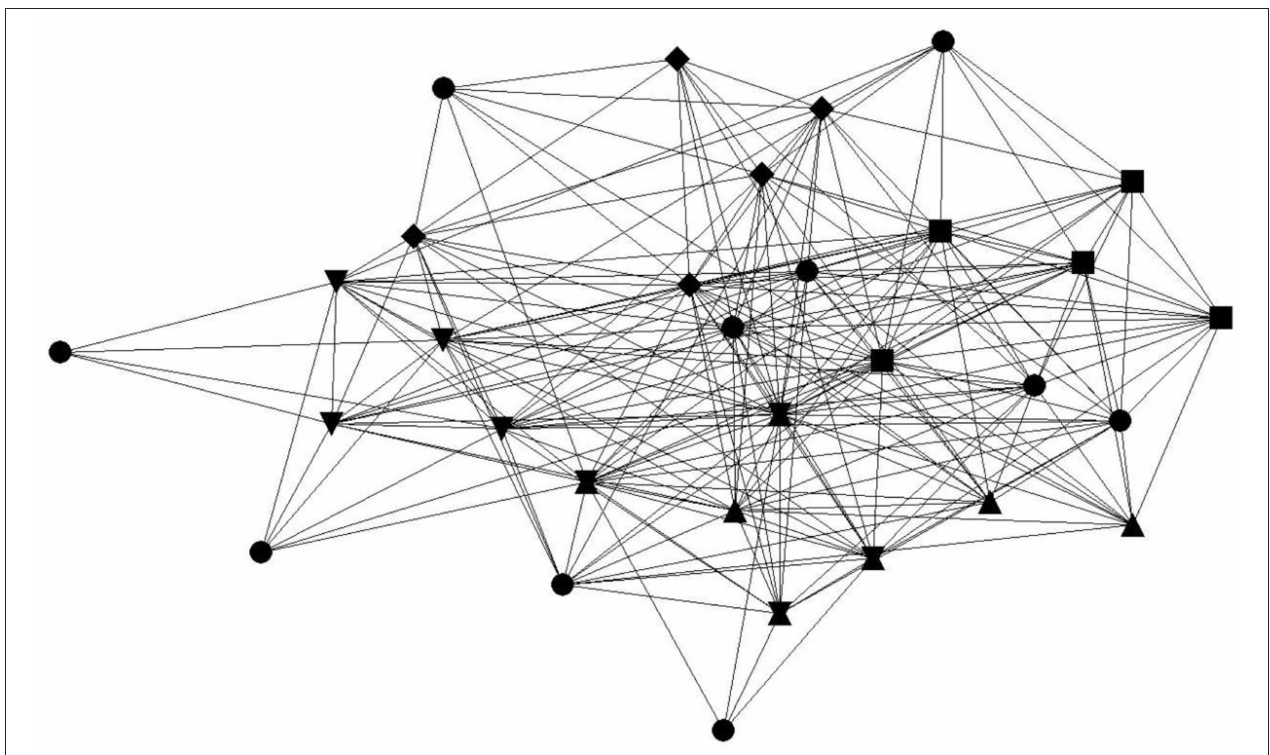
FIGURE 2 | This graph shows the network during to the 90-day cycle. Participants answered the survey question, “During PiPNIC, who was important to your learning about conferring?” The graph, constructed in UCINET, includes all participants ( n = 31). The circles are researchers, non-circles are educators, and the shape indicates the different schools. More highly connected nodes are moved to the center, while people with fewer connections are moved to the